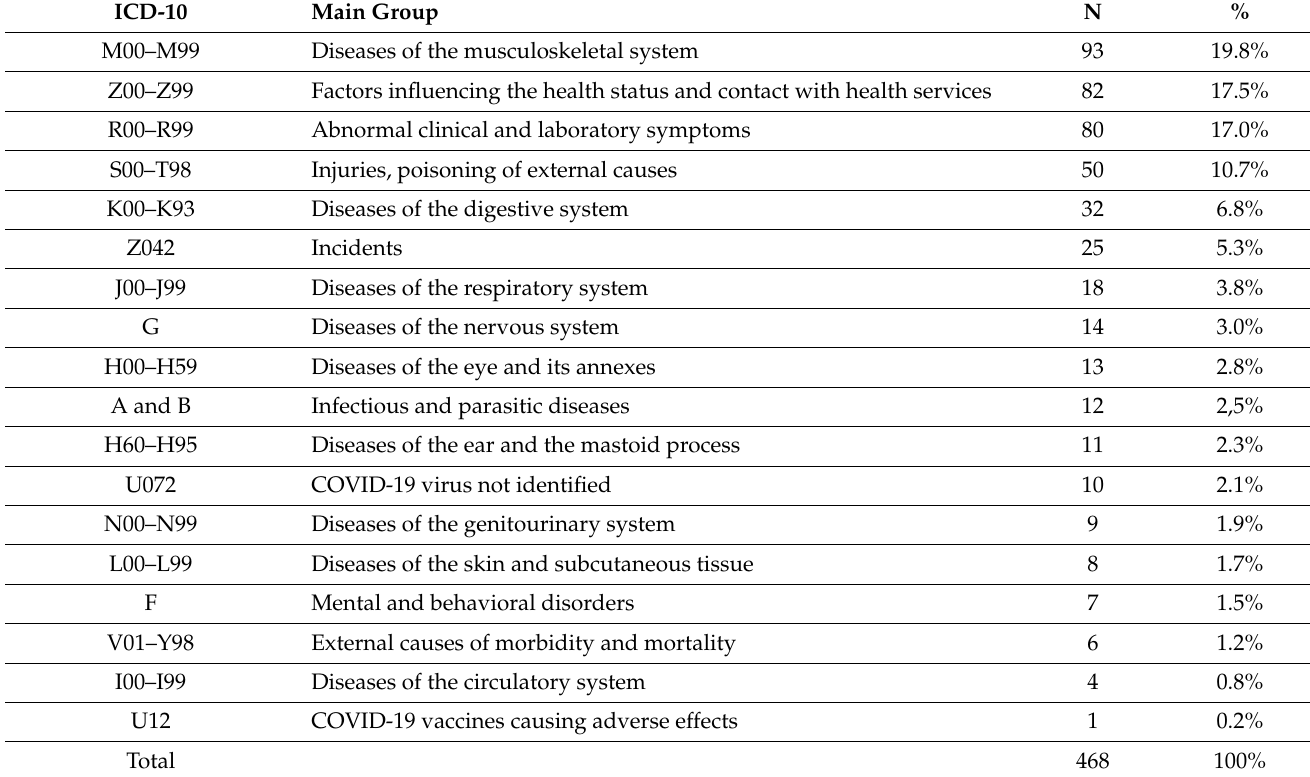
Table 1. ICD-10 diagnostics distribution among a total of n = 468 patients, exclusive of alcohol and drug screening queries, n = 832.